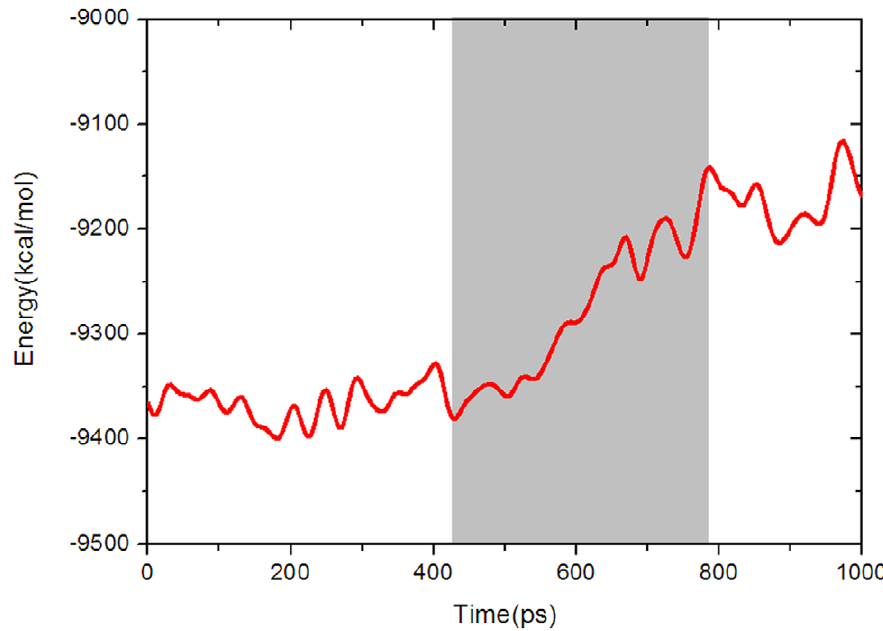
Figure 4. Free energy landscape along the conformational transition pathway of GK activation.